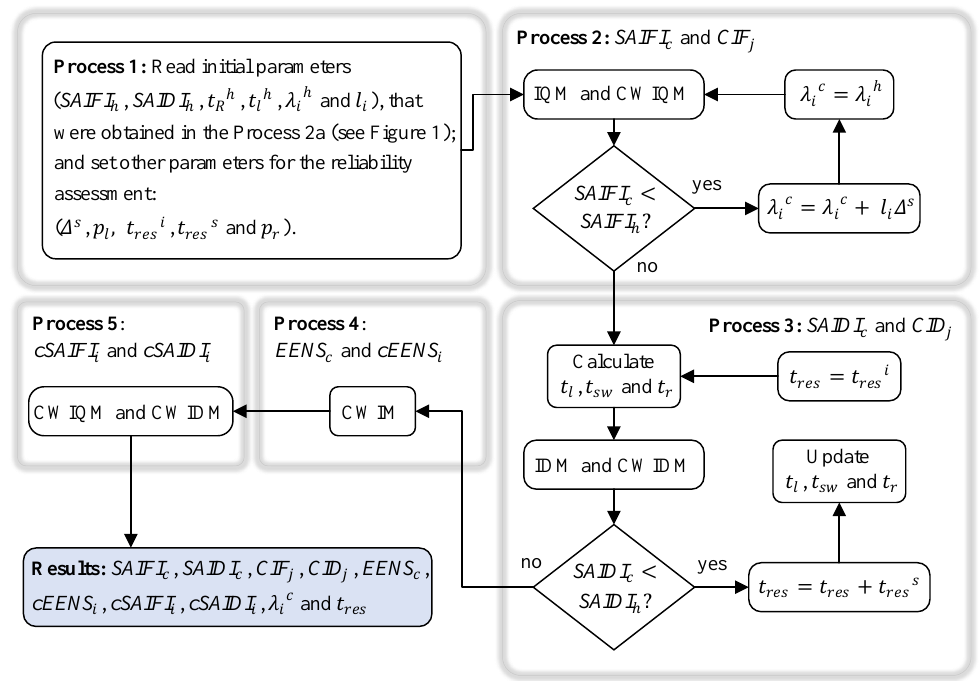
Figure 5. Flowchart for the analytical assessment of